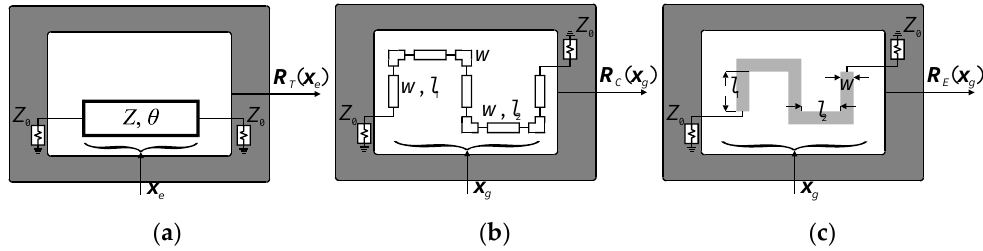
Figure 1. Illustration of structure representations (here, a phase shifter) supported by the design method: ( a ) ideal transmission line (TL) model R T ( x e ) with x e = [ Z θ ] T , ( b ) equivalent-circuit model R C ( x g ), and ( c ) high-fidelity electromagnetic (EM) model R E ( x g ). The vector of geometry parameters x g = [ w l 1 l 2 ] T is the same for R C and R E models.